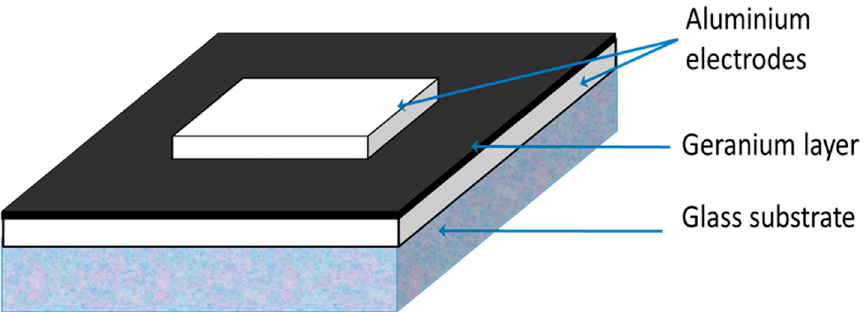
Figure 2. Metal–insulator–metal (MIM) structure used to study the electrical properties of geranium plasma polymer thin films.